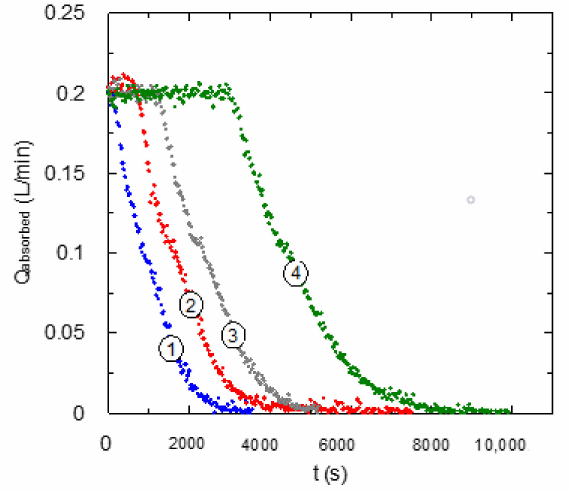
Figure 2. Influence of EDA concentration upon carbon dioxide absorption curve. Q G = 0.2 L · min − 1 . 1 (cid:13) C B = 0.1 mol · L − 1 ; 2 (cid:13) C B = 0.2 mol · L − 1 ; 3 (cid:13) C B = 0.3 mol · L − 1 ; 4 (cid:13) C B = 0.6 mol · L − 1